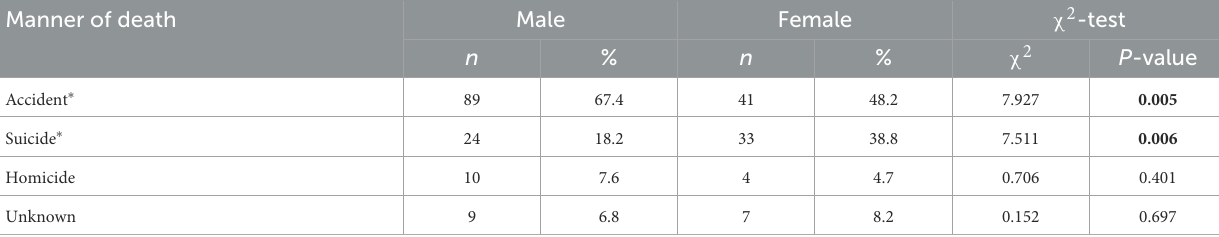
TABLE 7 Manner of death by sex in intoxication deaths from 2009 to 2021. Manner of